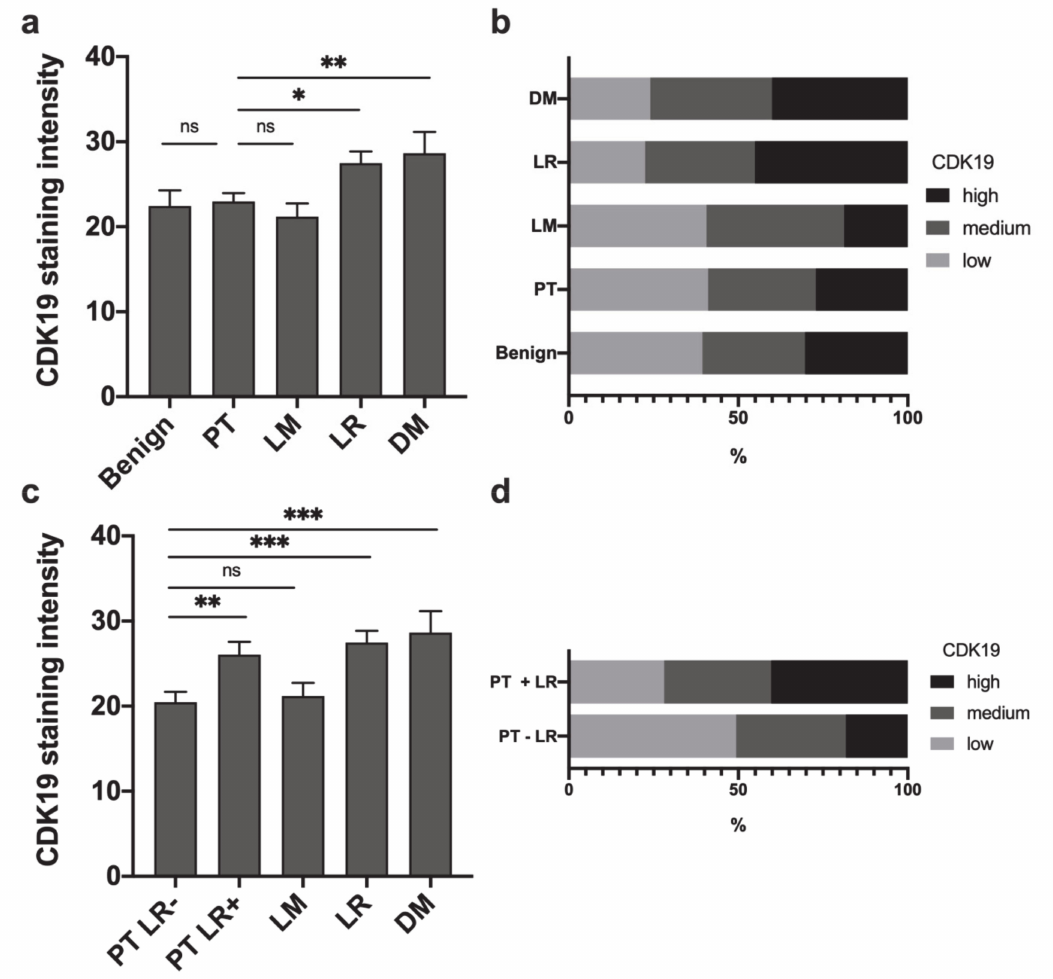
Figure 2. CDK19 is di ff erentially expressed in di ff erent HNSCC tissues. ( a , c ) Mean nuclear CDK19 expression in di ff erent tissue types (arbitrary units). ( b , d ) Distribution of CDK19 expression categories in di ff erent tissues. ns = not significant; * p < 0.05; ** p < 0.01, *** p <